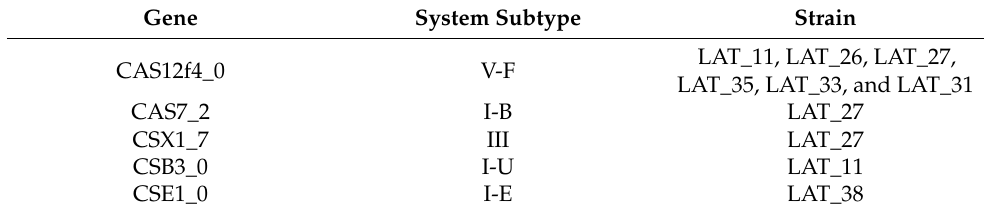
Table 3. CRISPR-Cas system subtypes found in the analyzed